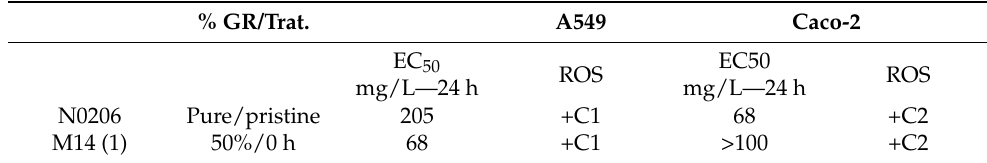
Table 9. Toxicity results for samples analyzed. % GR/Trat.